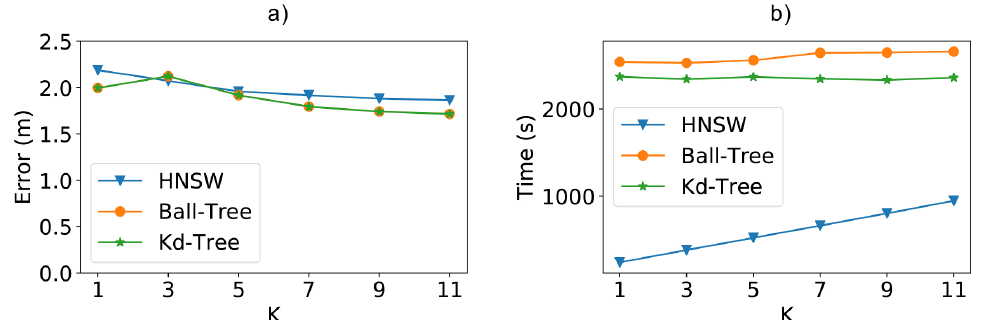
Figure 13. ( a ) Positioning error and ( b ) total time (fitting + classification) when using the real-world UJI indoor dataset and varying the k